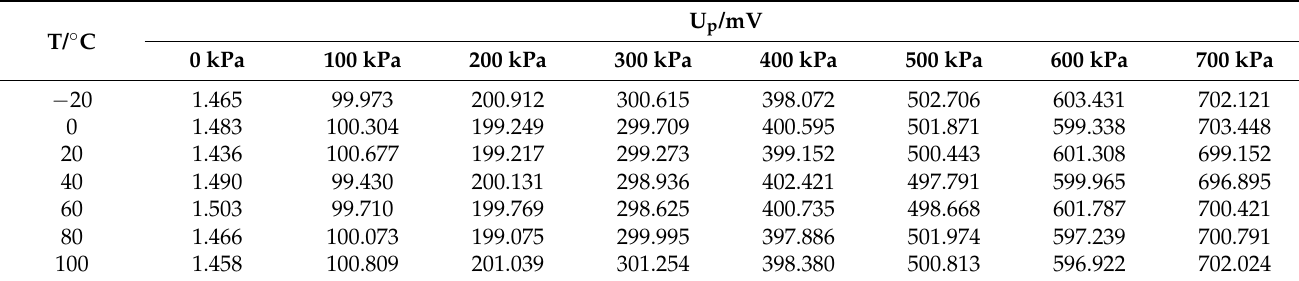
Table 5. Temperature compensation results of Sensor A based on the DE–BP algorithm.